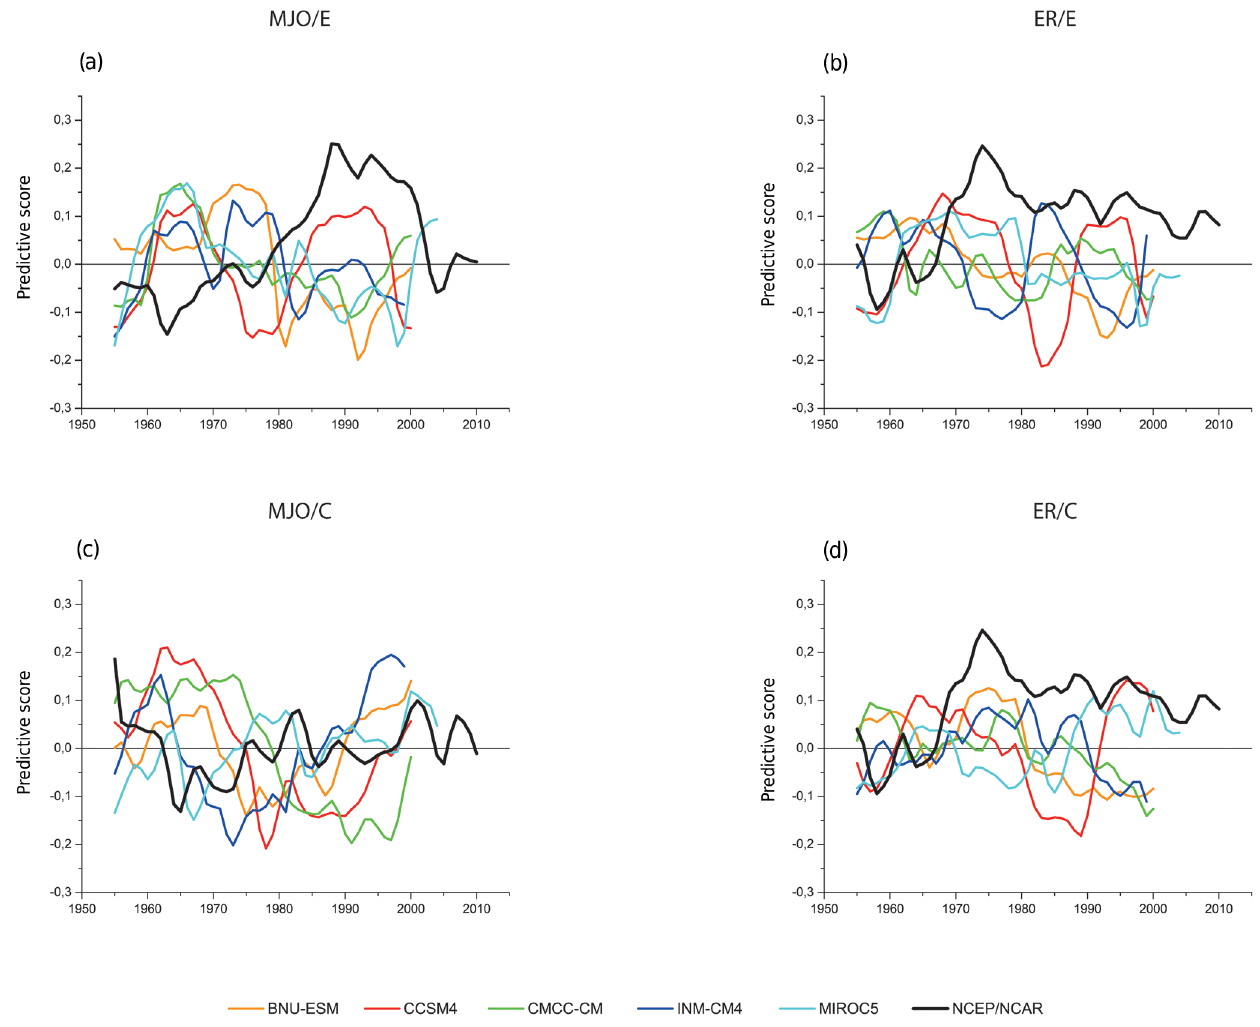
Figure 9. Evolution of the predictive score (see Eq. 1 in the text) for MJO (a, c) and ER (b, d) and for EP (a, b) and CP (c, d) El Niño events for five CMIP5 models and the NCEP/NCAR Reanalysis. Note that the mean was removed for the models but not for the